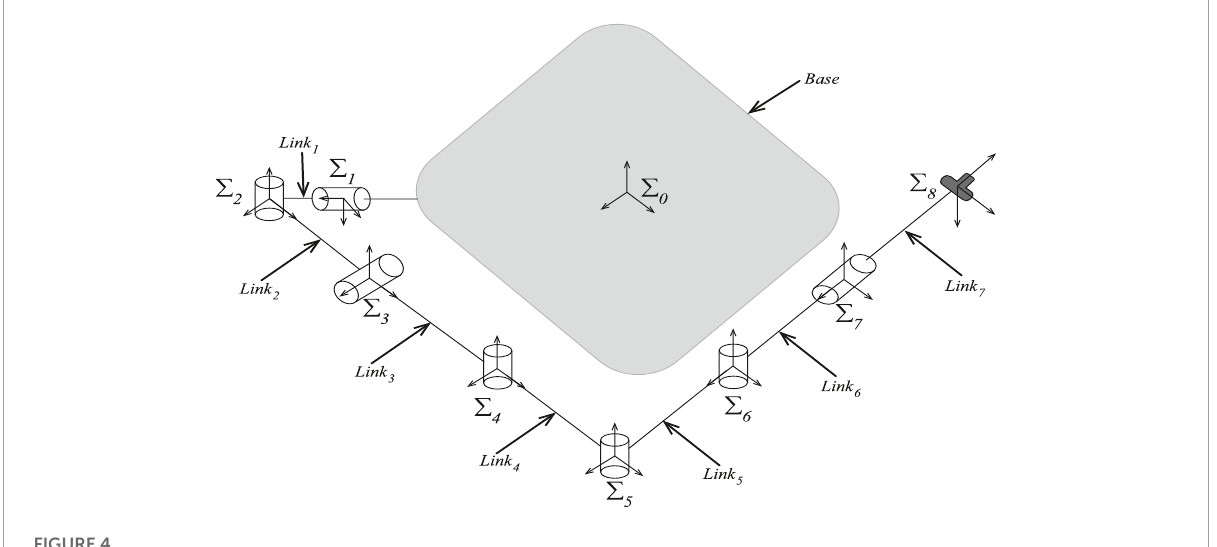
FIGURE 4 The rest configuration of the space robot and the coordinates systems of the joints.